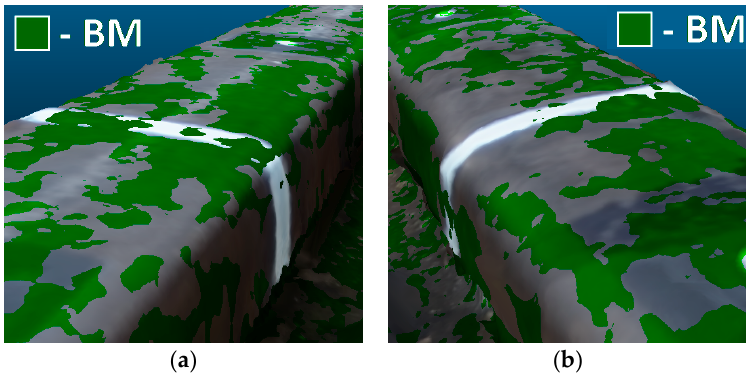
Figure 11. Penetrate maps of the 3D models: basic model (BM; green color) in relation to the profile model (PM) ( a ) on the left; ( b ) on the right rail.